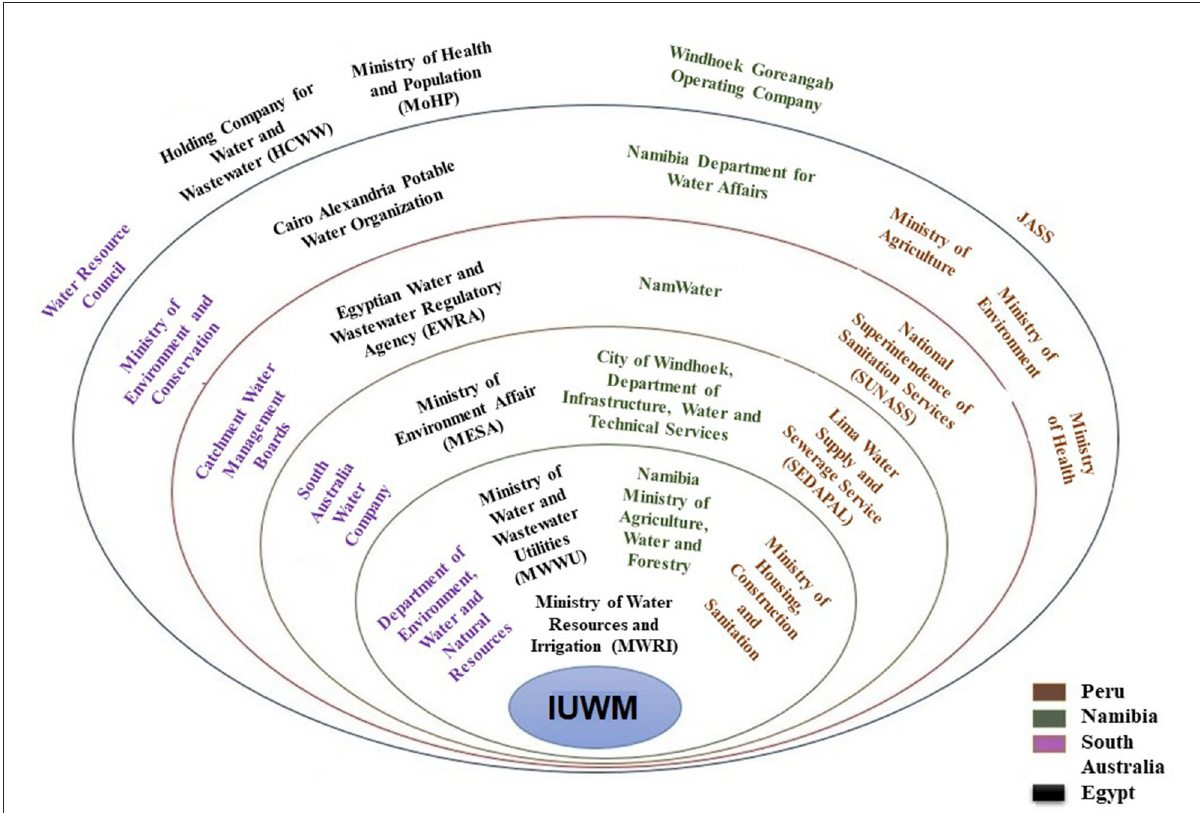
FIGURE5 Onion chart of stakeholders in the water sector in the three case studies and in Egypt. Stakeholders are arranged according to their influence in the transition process toward water sensitive urban design. The goal to develop an integrated urban water management approach is at the center, from there the stakeholder are arranged in layers from high influence on decisions (inner layer) to lower influence of actors in the environment (outer layer). IUWM, integrated urban water management; JASS, Juntas Administradoras de Servicios de Saneamiento in Peru. The chart is based on the literature review and on the stakeholders’ interviews. Background information can be found in Supplementary Appendix II and for details see result section and Supplementary Appendix